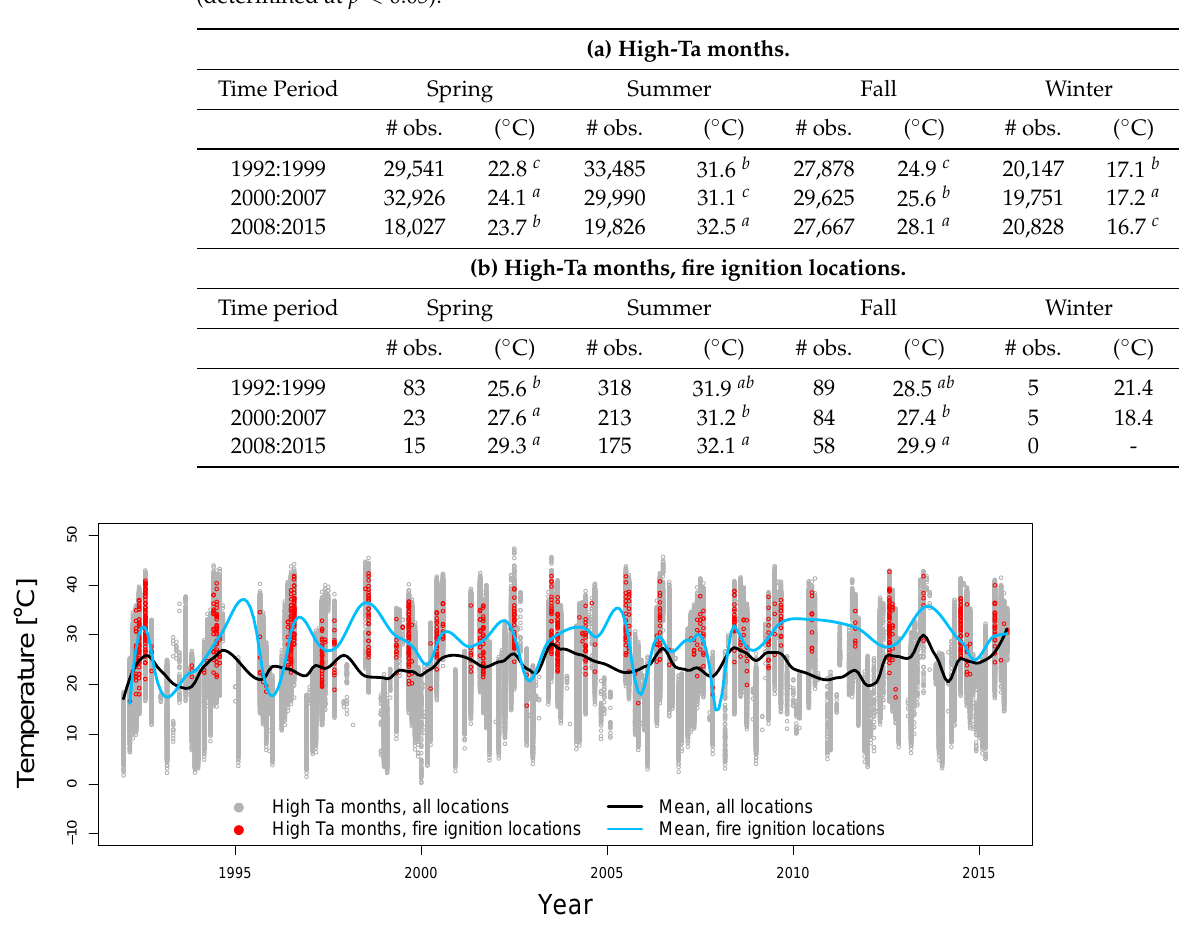
Table 1. Seasonal air temperature (Ta: ◦ C) differences between 8-year time periods from 1992 to 2015 in the Sierra Nevada region. Ta differences were analyzed for high-Ta months (Section a ) and locations with high-Ta months that experienced a concurrent wildfire ignition (Section b ). The number of observations in each category is indicated in the table, and significance is indicated by differing letters (determined at p < 0.05).